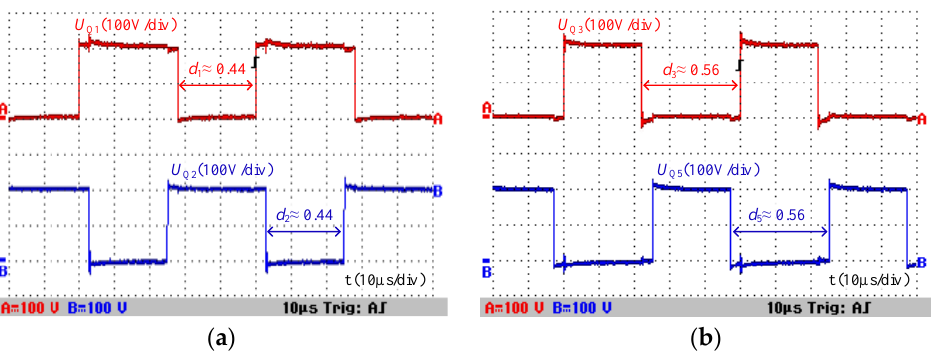
Figure 16. The PWM voltage of power semiconductor Q 3 and inductor current i L1 .